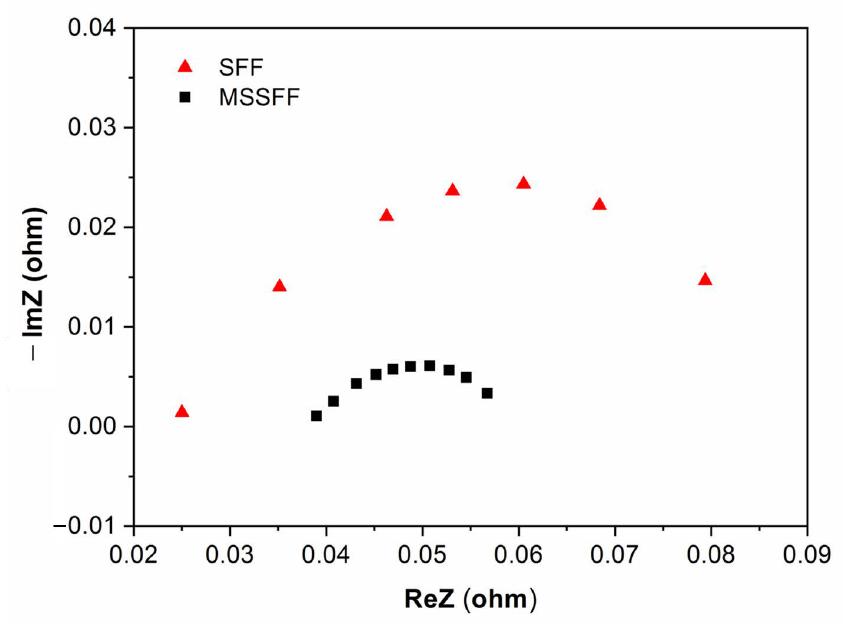
Figure 7. Nyquist plot of PEMFC for SFF and MSSFF. The start of the semi-circle indicates Ohmic resistance (R O ) and the diameter of the semi-circle when completed indicates kinetic resistance (R k ) in the Nyquist plot. It can